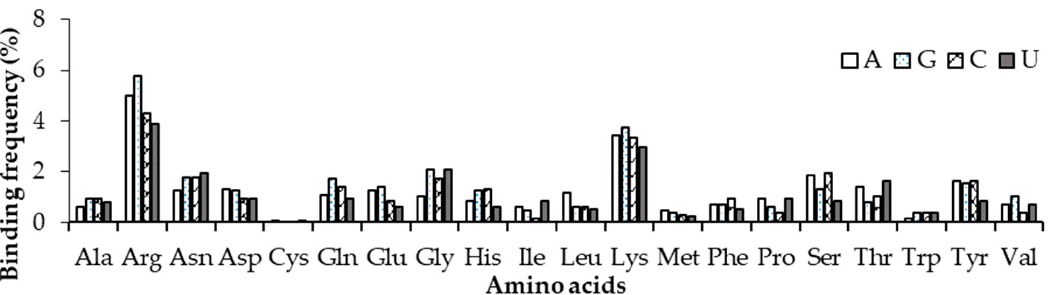
Figure 7. Normalized amino acid nucleotide contact frequency in non-ribosomal protein–RNA complexes at 3.5 Å.